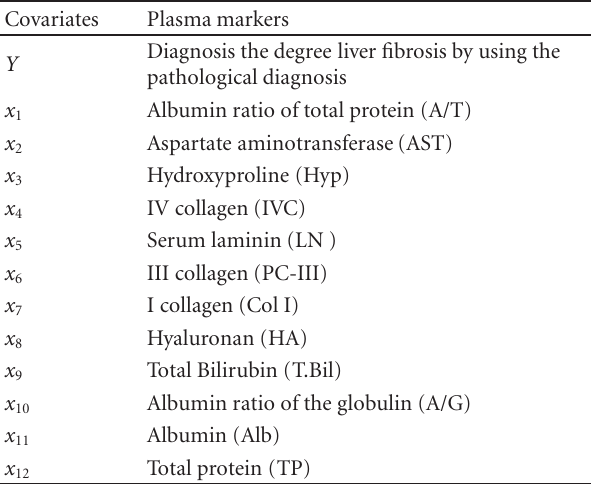
Table 4: List of covariates for plasma markers. Covariates